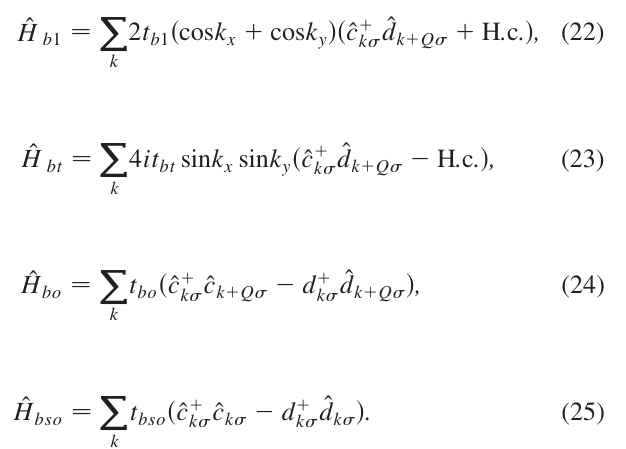
FIG. 6. Fermi surfaces and band dispersions in the presence of the S 4 symmetry breaking: (a),(e) t ¼ 0 : 05 in Eq. (23); (c),(g) t (b),(f) t bt Fig. 5. The y axis for (e)–(h) is in units of